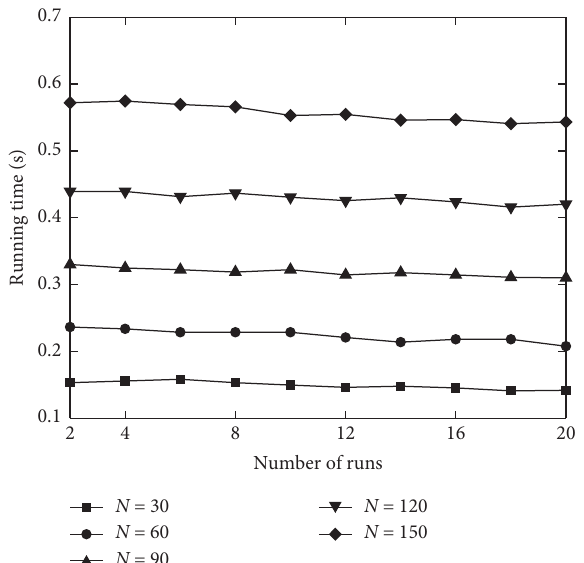
Figure 9: Running time under different population sizes.